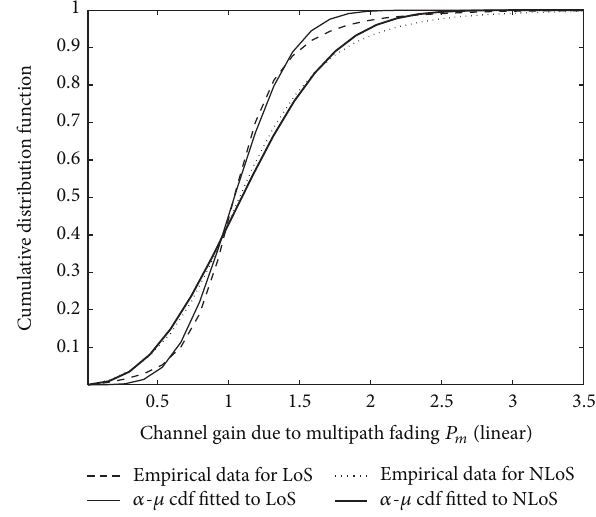
Figure 7: The empirical and fitted cdfs of shadowing in the LoS and NLoS scenarios.